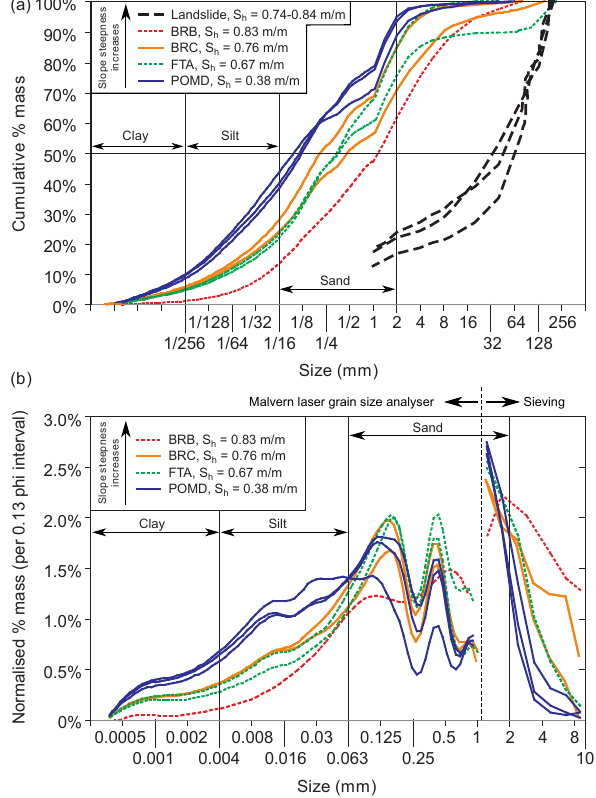
Figure 7. (a) Cumulative grain size distributions measured for the sources of sediment in Bald Rock basin (see sites location in Fig. 3). Line patterns reflect hillslope steepness at the sites ( S h is mean hill- slope gradient) and type of source (soil or landslide). Note the log 2 scale on the x axis. (b) Non-cumulative grain size distribution of the fraction finer than 10mm of soil samples. Line patterns are the same as in (a) . Grain size distributions of fraction coarser and finer than 1mm were determined using sieves and a Malvern laser grain size analyser, respectively. For both methods, the percent mass has been normalised to represent the value per 0.13 φ interval. Lines connect- ing the curves produced with the two methods (at 1mm) have been removed for clarity; the peak at the transition is real: sediment in the fraction 1–2mm is significantly more abundant than sediment in the fraction 0.5–1mm. Note the log 2 scale on the x axis.